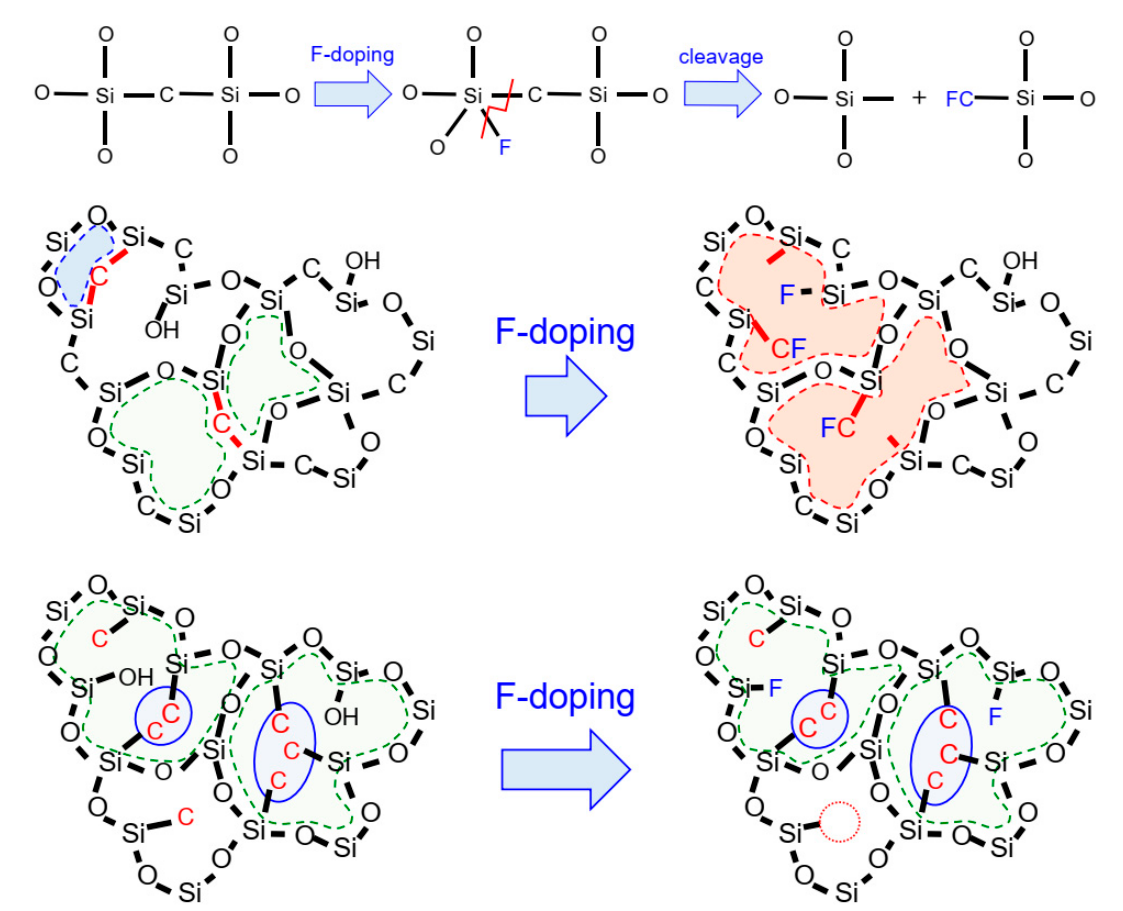
Figure 10. A schematic image of the effect that fluorine doping exerts on pendant–type and bridged–type organosilica network structures calcined at 300–350 °C under a N 2 atmosphere.